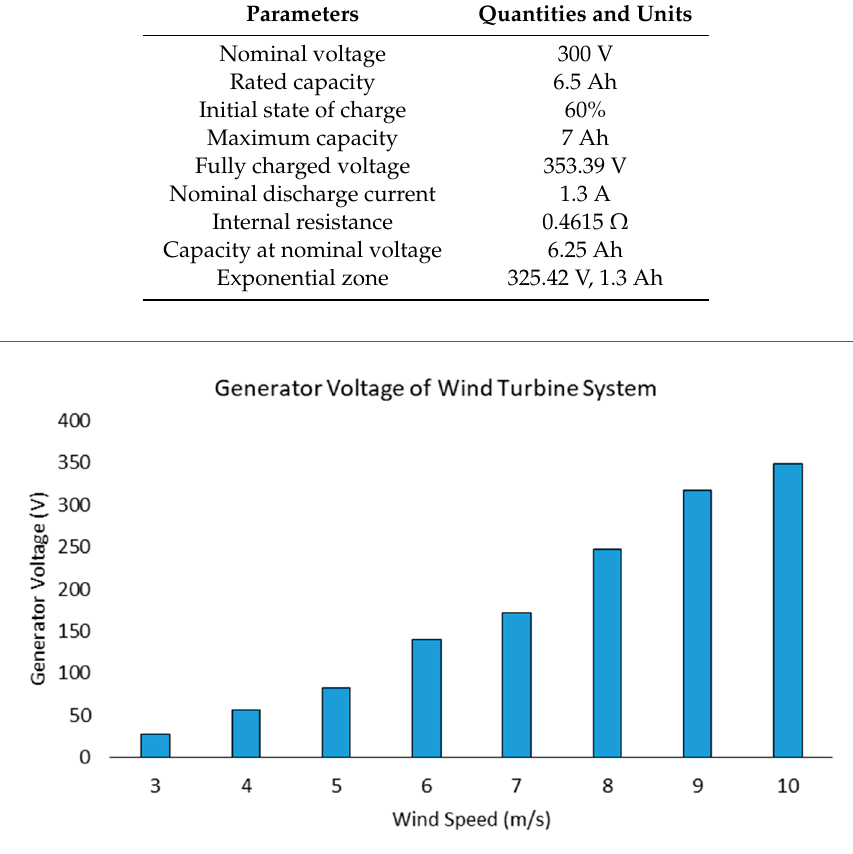
Figure 10. Generator voltage of wind-turbine system. Table 4. Parameters of battery.